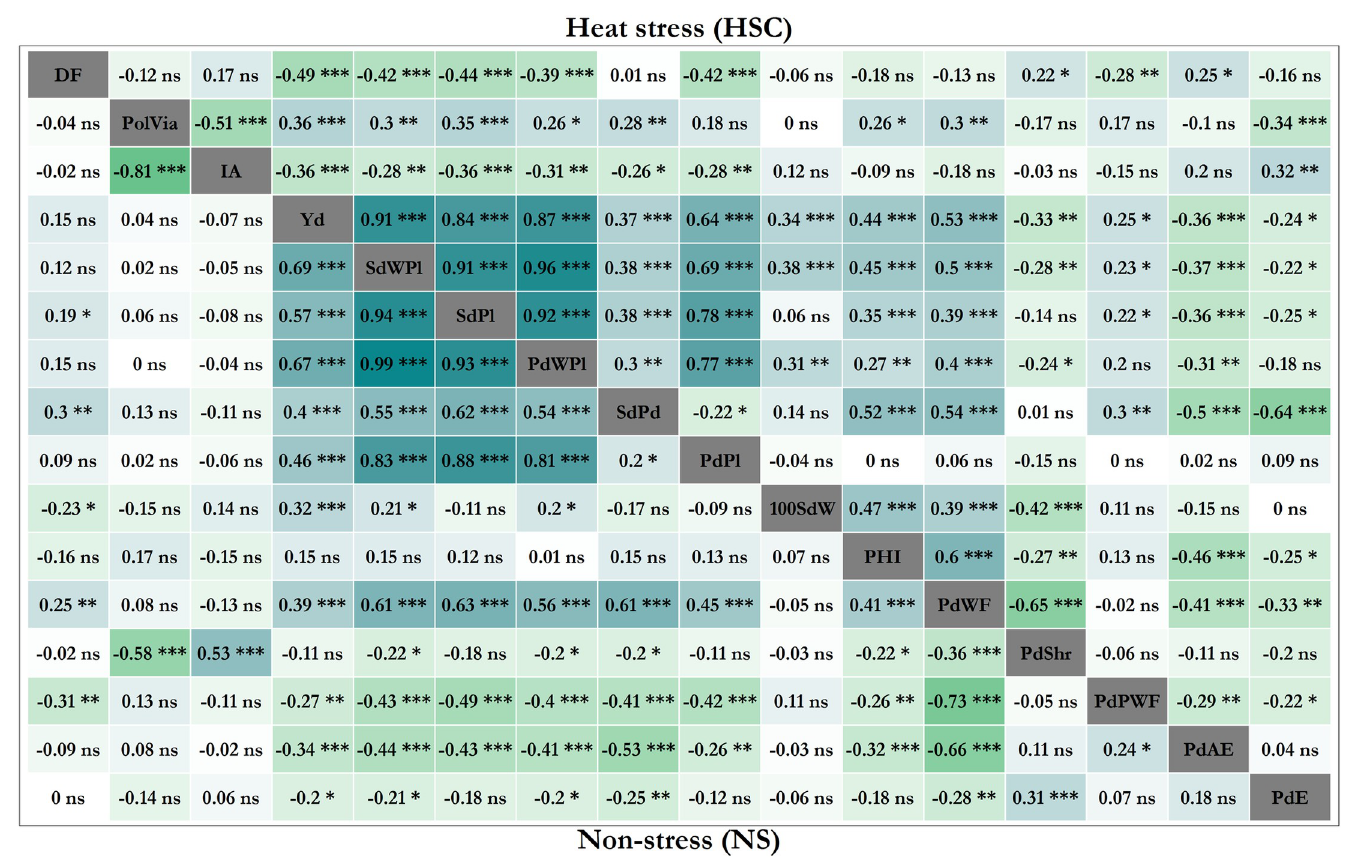
Fig 5. Phenotypic trait correlations in the IJR x AFR298 population, in non-stress (NS, lower left) and heat stress conditions (HSC, upper right). For abbreviations see Table 1. Pearson correlations shown with significance levels � , �� , ��� as p values > = 0.05, 0.01 and 0.001, respectively.